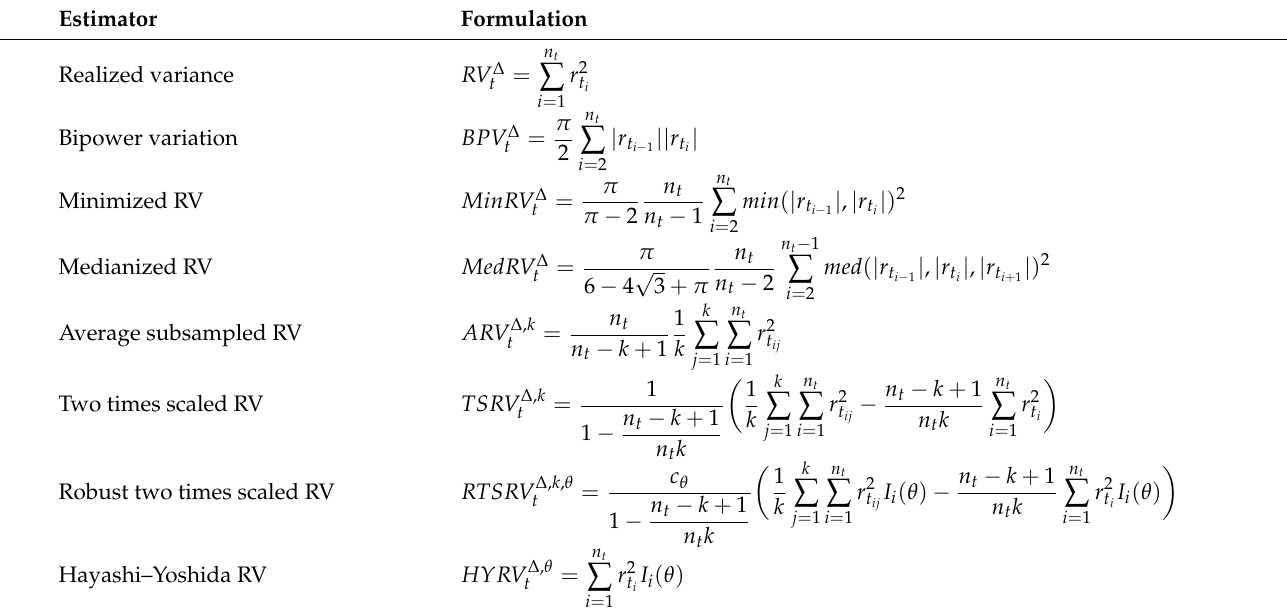
Table 2. Competing realized estimators of integrated